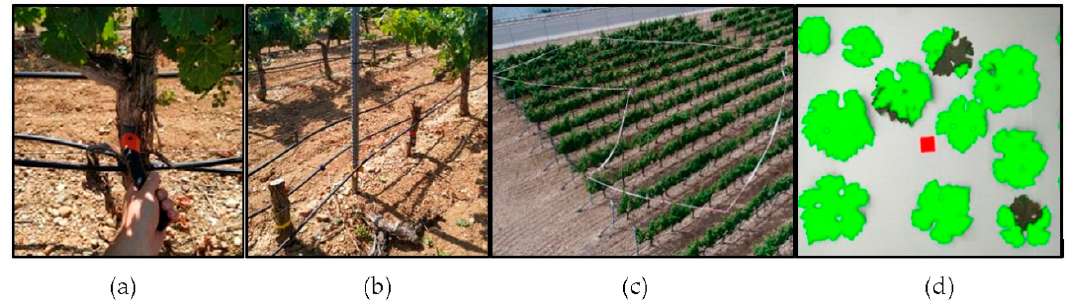
Figure 3. ( a ) Removal of the vines; ( b ) Detail of the removed vines; ( c ) Marked pixels in the vineyard and ( d ) Example of the leaf area measurements using the Easy Leaf Area application.